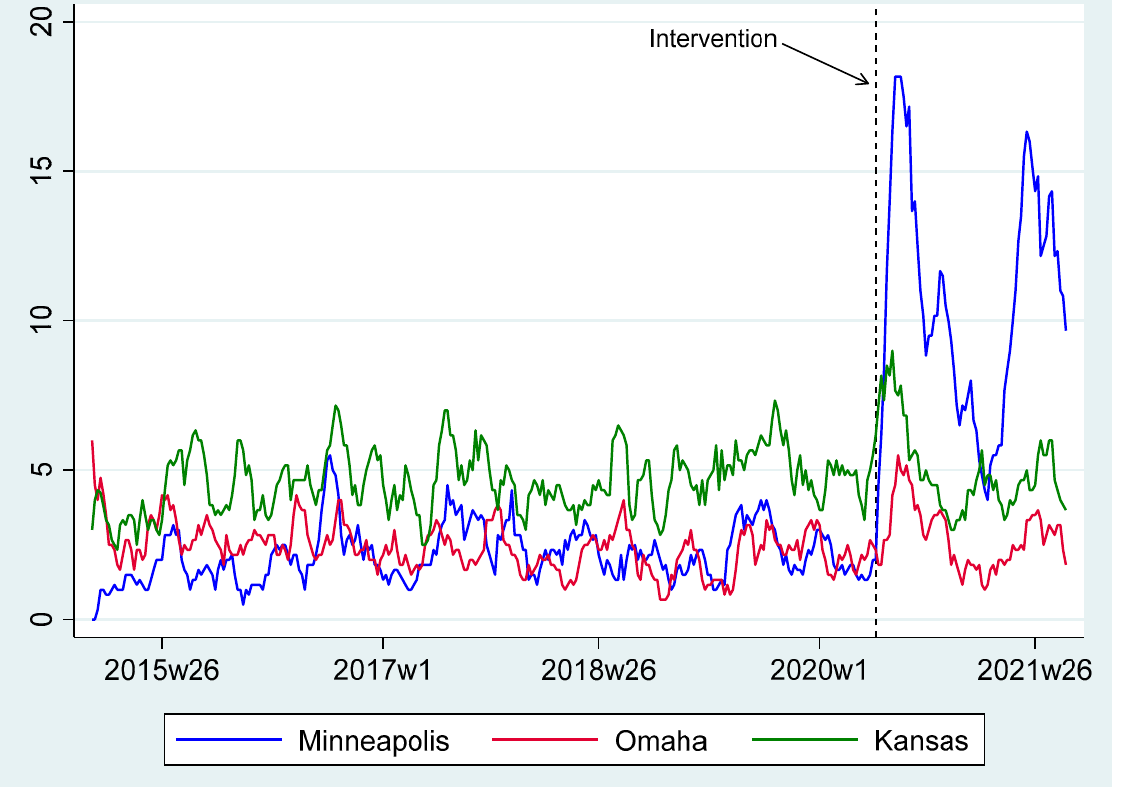
Figure 1. Five-week moving average time series plot of weekly counts of firearm incidents. Note: The dashed line represents the week in which George Floyd was killed (the 21st week of 2020).